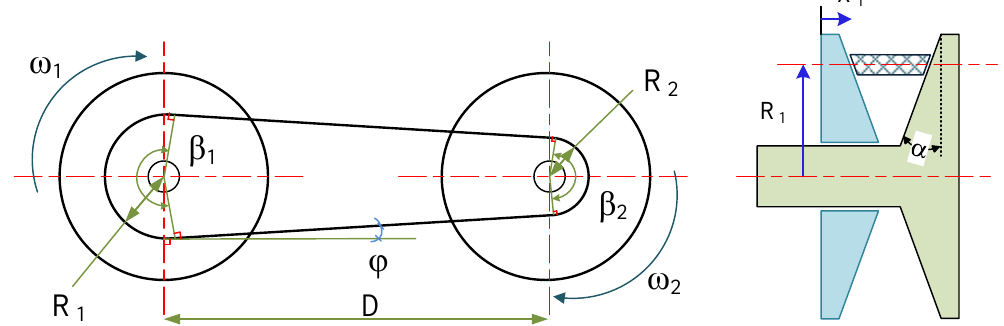
Figure 5. Geometrical description of a belt CVT drive.